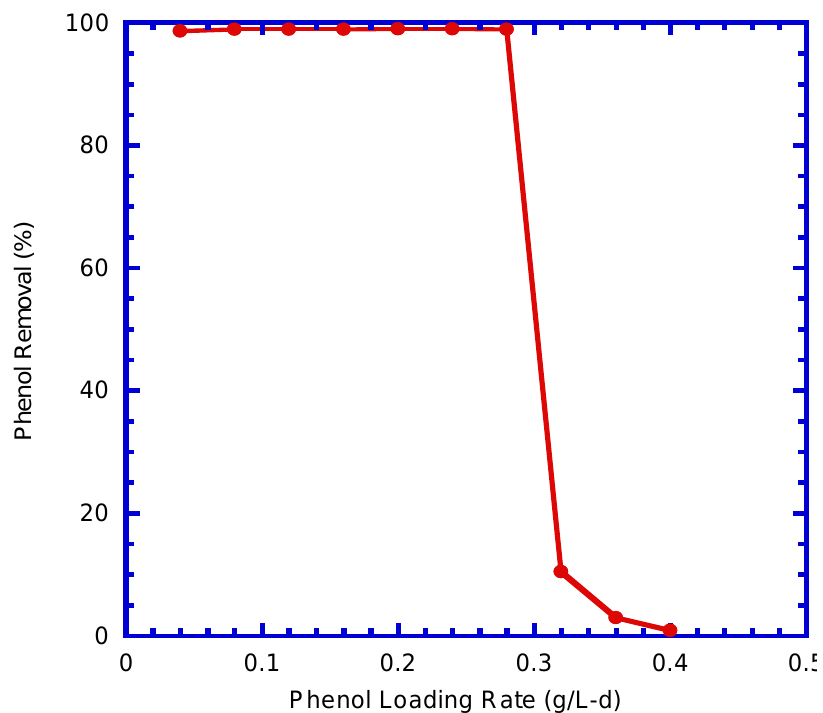
Figure 14. Effect of phenol loading rate on phenol removal in the continuous-flow bioreactor. Figure 14. E ff ect of phenol loading rate on phenol removal in the continuous-flow